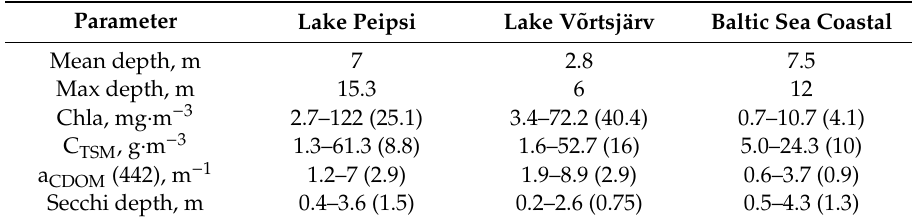
Table 1. Morpho-dynamical data and bio-optical parameters of the study sites (minimum, maximum and median